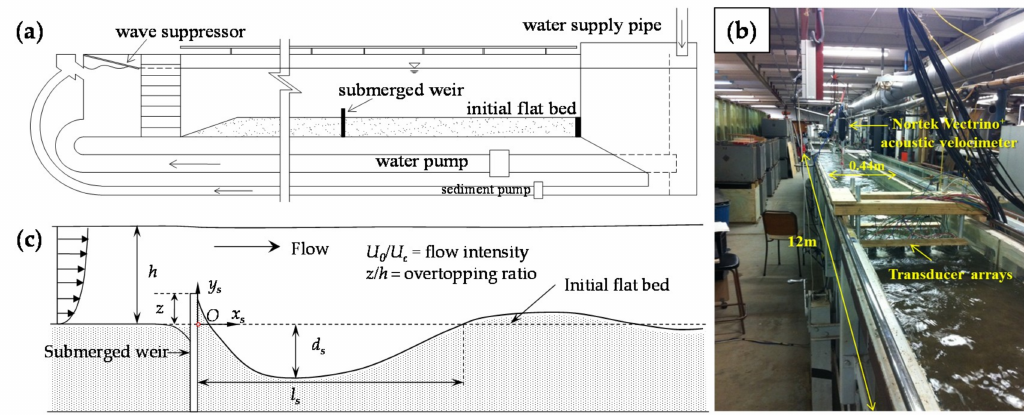
Figure 1. Experimental set-up and definition of experiential parameters: ( a ) schematic of experimental flume, reproduced from [3]; ( b ) experimental flume and measurement devices; ( c ) definition of experimental parameters in